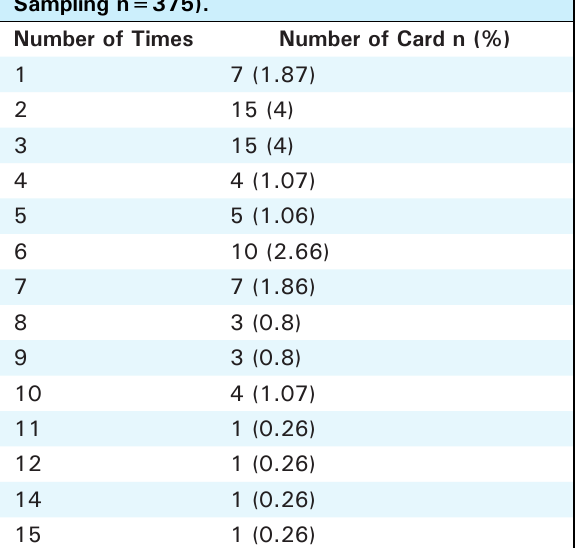
Table 6. Frequency of Card in first year (Random Sampling